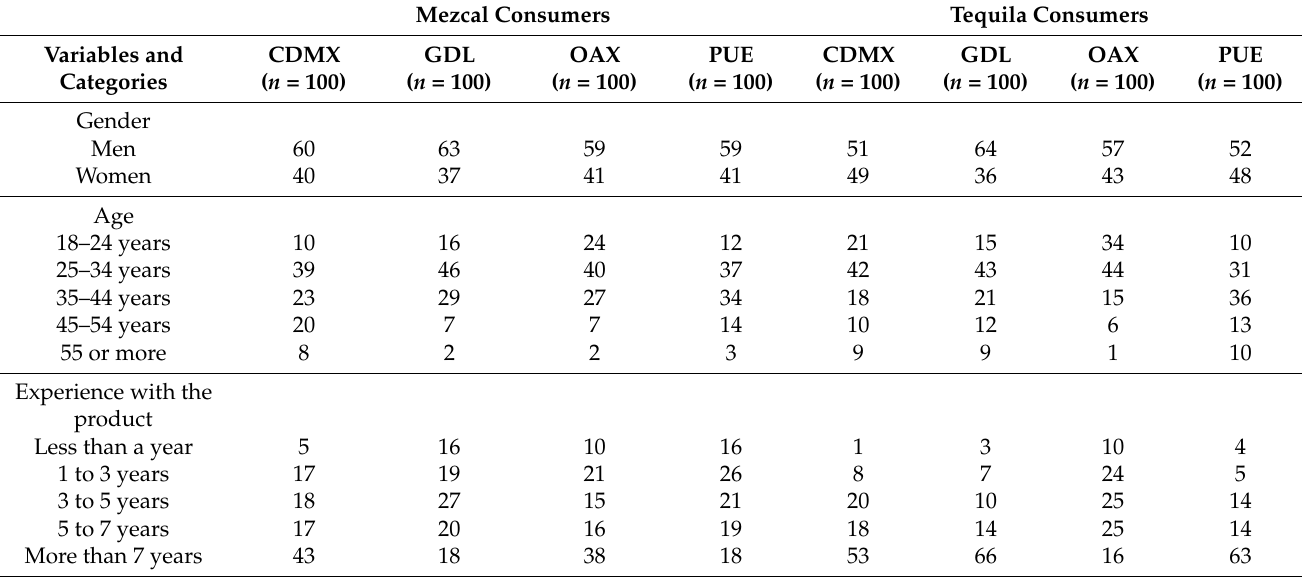
Table 1. Sociodemographic characteristics (number of individuals) and consumption habits of the participants in the survey ( n =